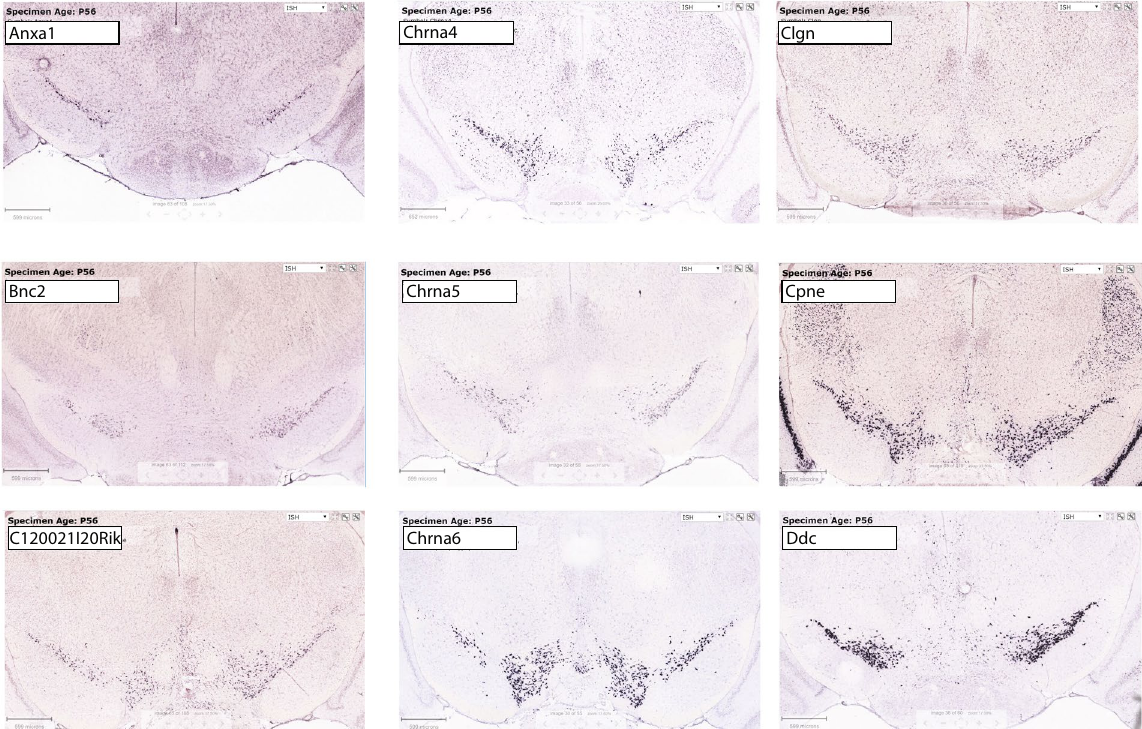
Figure 3. Examples of highly enriched transcripts in midbrain dopamine neurons. Shown are the first 9 genes of Table 1 with coronal in situ hybridization patterns available in the Allen Brain Atlas 25 . All show a regional pattern consistent with high and or/specific enrichment in midbrain dopamine neurons. Some (e.g. Anxa1) appear to only be expressed in a subset of the neurons, while others (Cpne) are highly expressed in SN/VTA but also show expression in additional populations. Images are from